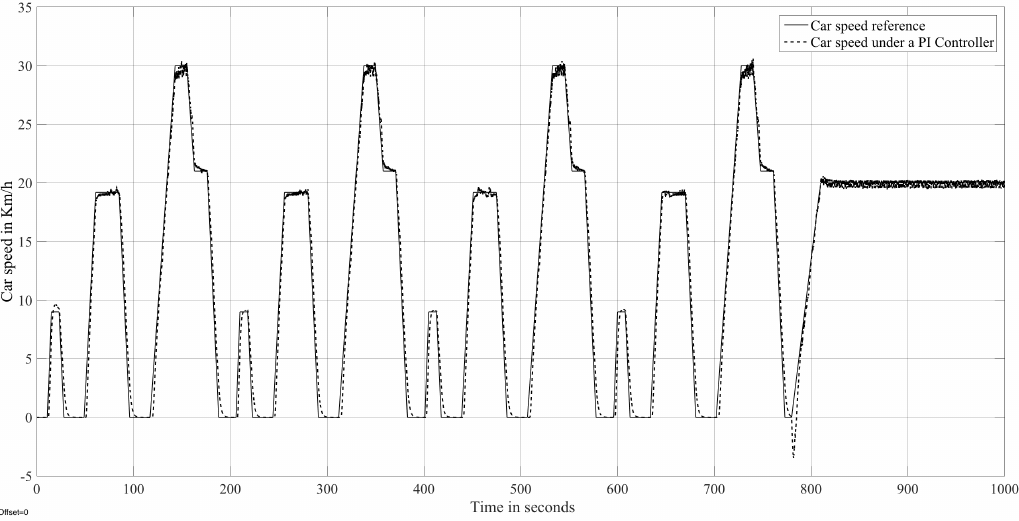
Figure 11. Car speed with the system under a PI controller.